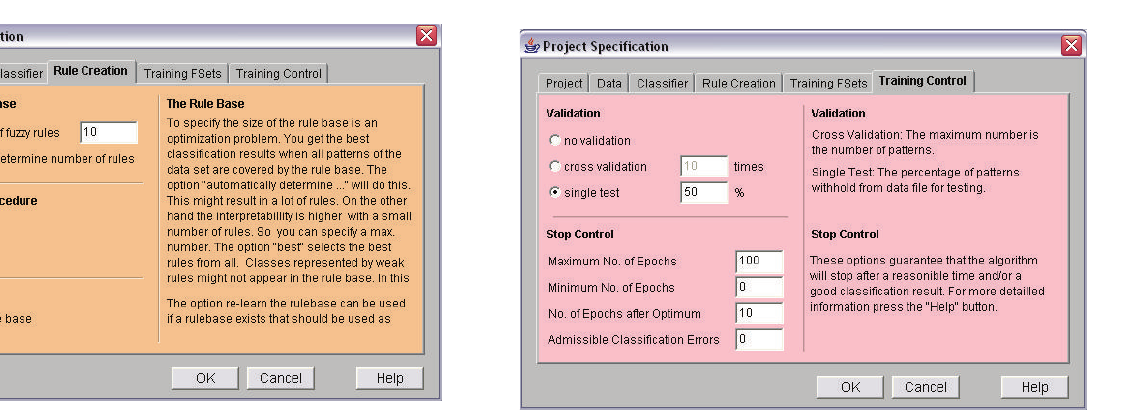
Figure 5: New Project’s Rule Creation tab.